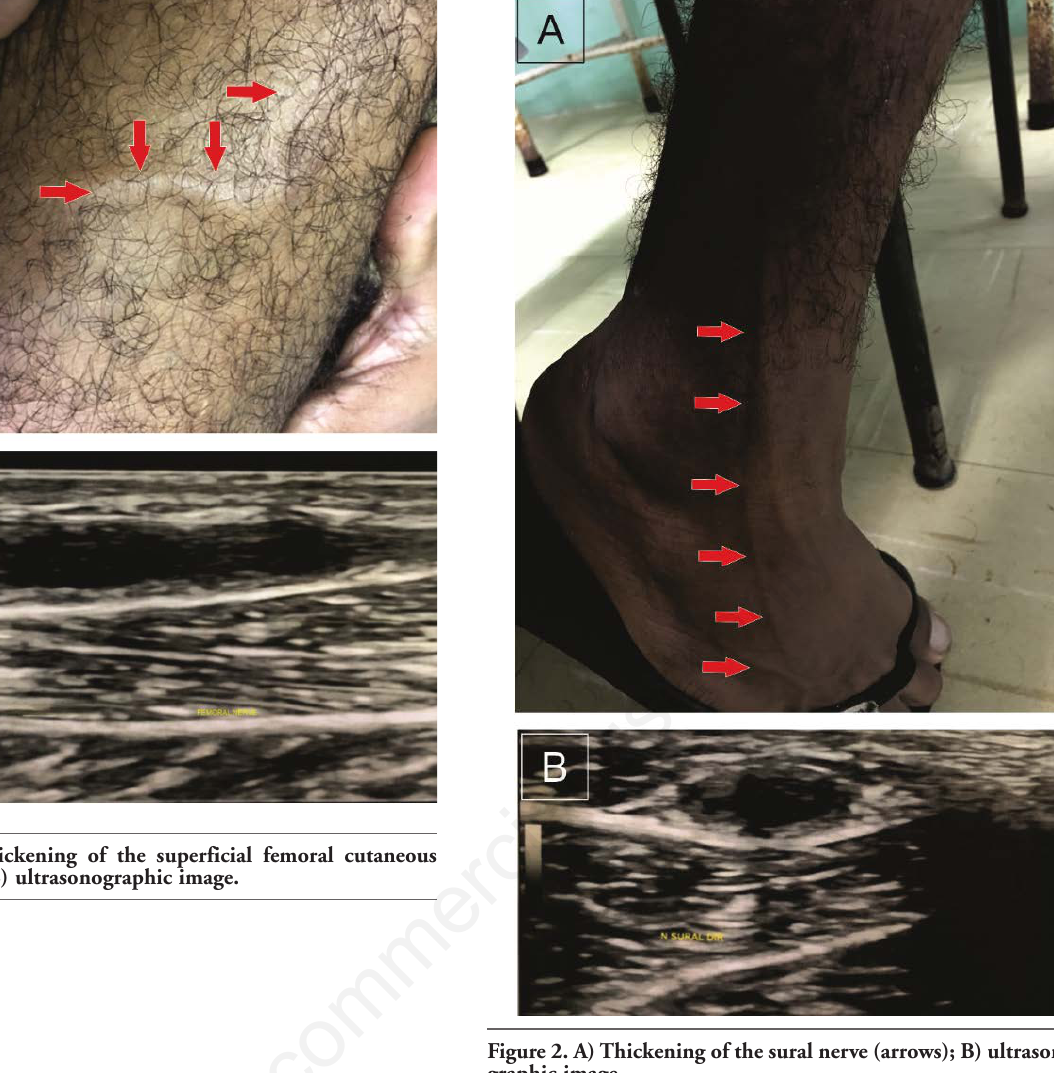
Figure 2. A) Thickening of the sural nerve (arrows); B) ultrasono- graphic